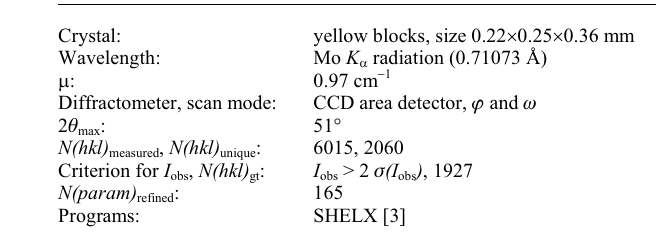
Table 1. Data collection and